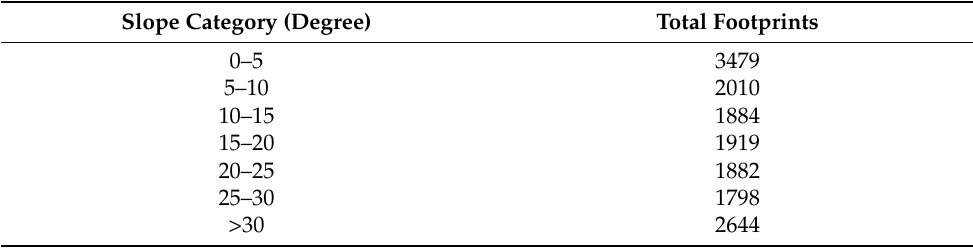
Figure 1. The four study sites (red) with selected Global Ecosystem Dynamics Investigation (GEDI) footprints (black) across the Australia states Victoria, New South Wales, and Australian Capital Territory. Table 2. Number of footprints per terrain slope